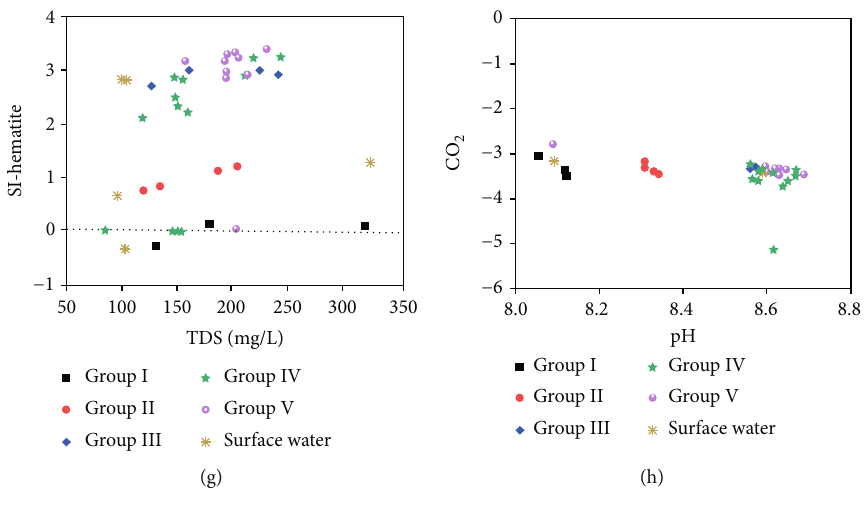
Figure 8: Saturation index of main minerals.